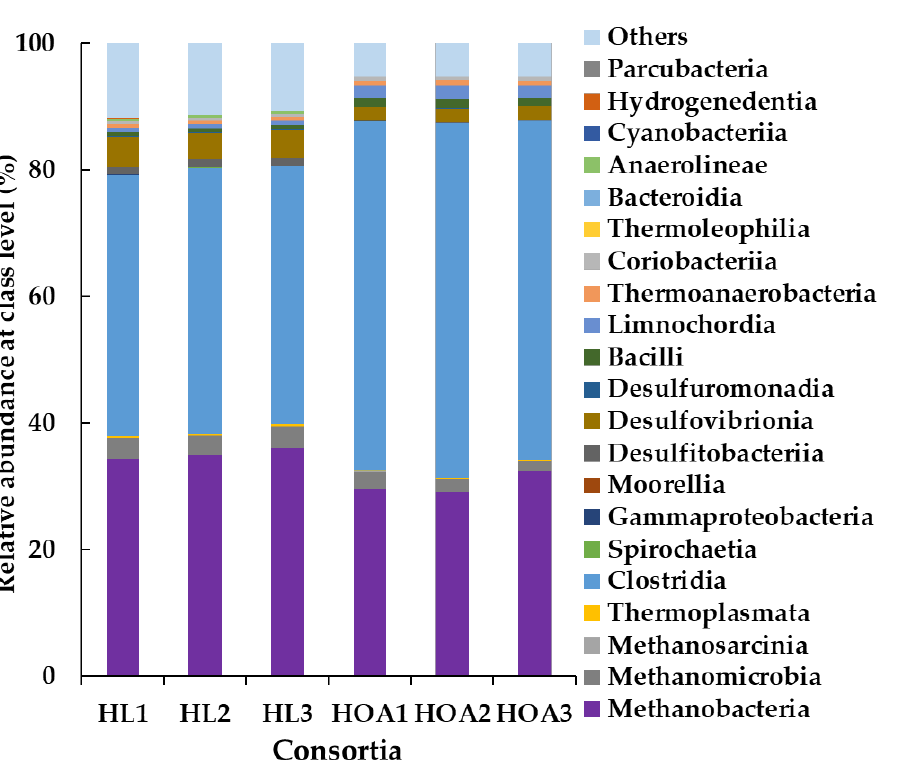
Figure 6. Microbial composition of the HL and HOA consortia, showing the major microorganisms (assessed in triplicate) based on 16S rRNA gene sequence. Table 3. Minor microbial groups detected only in one consortium of the HL and HOA